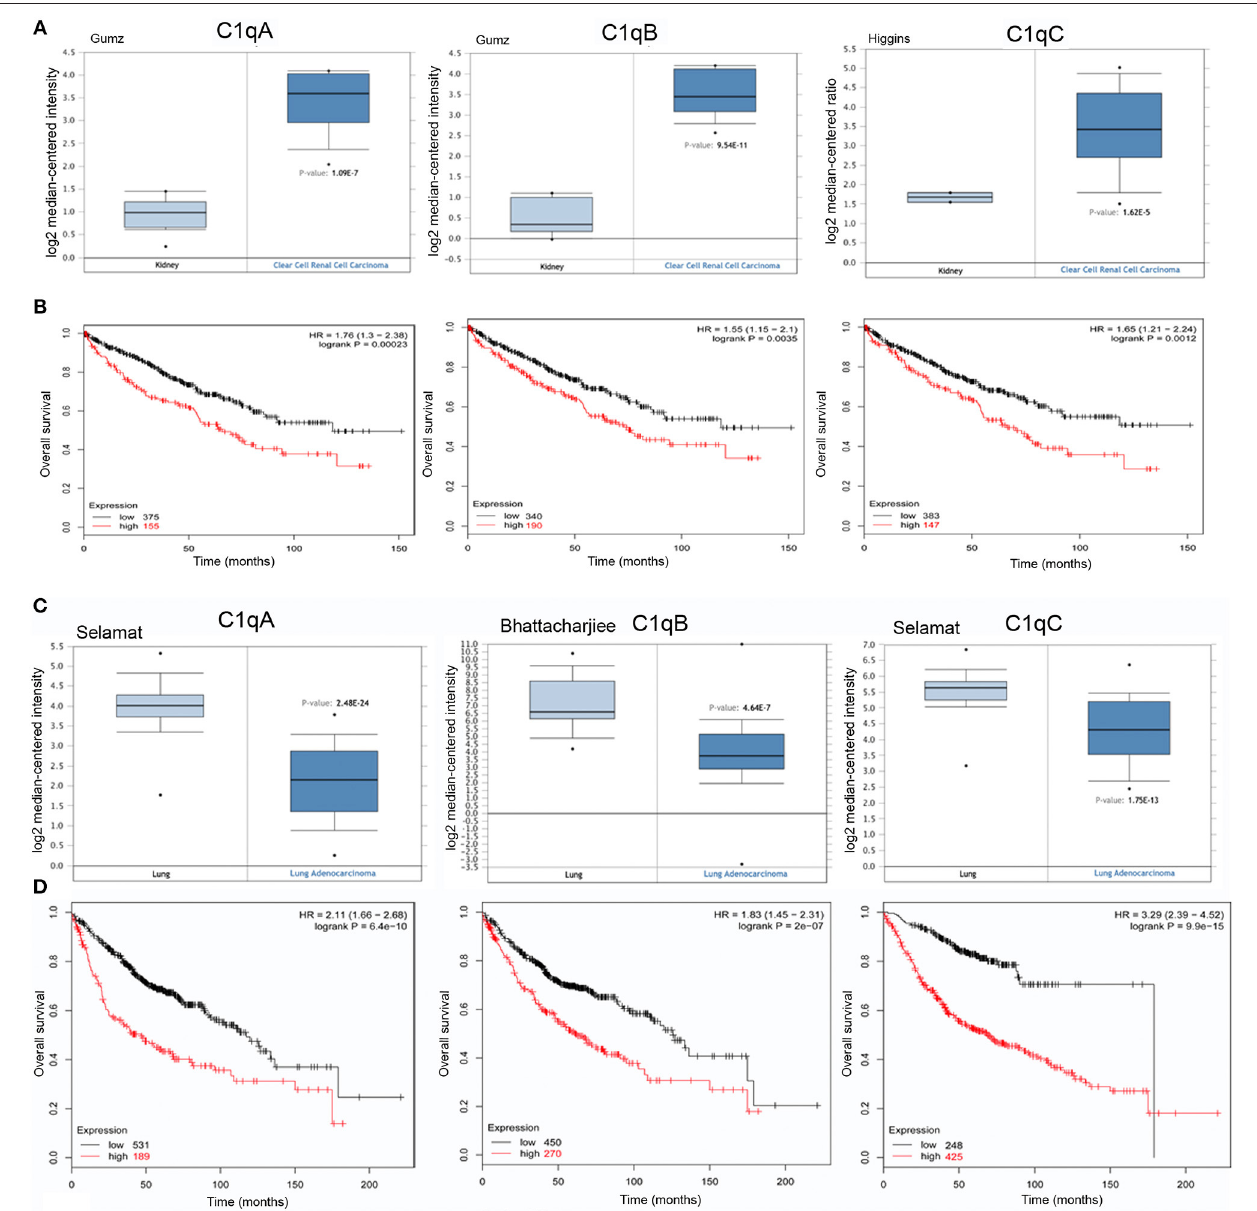
FIGURE 3 | Pathological significance of C1q expression kidney and in lung cancer. Gumz’s dataset have explored C1QA and C1QB mRNA expression in kidney, whereas Higgins’ dataset were used for C1QC mRNA expression. A higher C1q expression was detectable in CCRCC cancer than that in normal tissue (A) , p < 0.05. According to the data from Kaplan-Meier plotter, C1q mRNA expressions were negatively related to an overall survival rate of the patients with CCRCC (B) . HR, hazard ratio. Selamat’s dataset have revealed a lower C1QA and C1QC mRNA expression in lung adenocarcinoma that in normal lung tissues (C) , whereas Bhattacharjiee’s dataset was used for C1QB , but the results were in accordance with Selamat’s one. There was a negative association between C1q mRNA expression and a favorable prognosis in patients with lung cancer, for Kaplan-Meir plotter (D) . HR, hazard